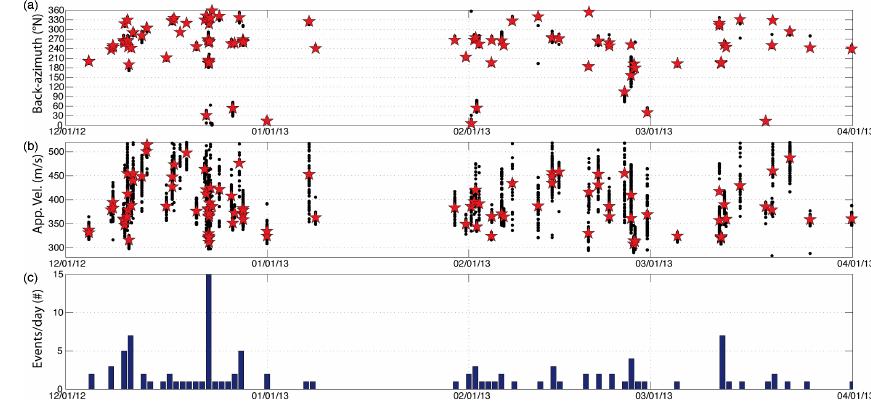
Figure 9. (a) Back azimuth and apparent velocity (b) of infrasonic detections (black dots) of 103 signals (red stars) showing infrasound wave parameters consistent with what expected by snow avalanches identified by the infrasound array between December 2012 and March 2013. (c) Number of eventsday − 1 during the 2012–2013 winter season.